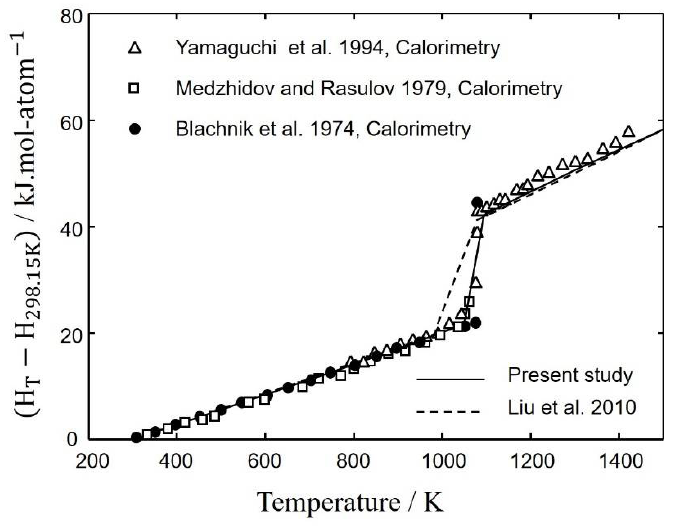
Figure 5. Calculated heat content (H T -H 298.15K ) of SnTe as function of temperature along with experimental data from [81–83].